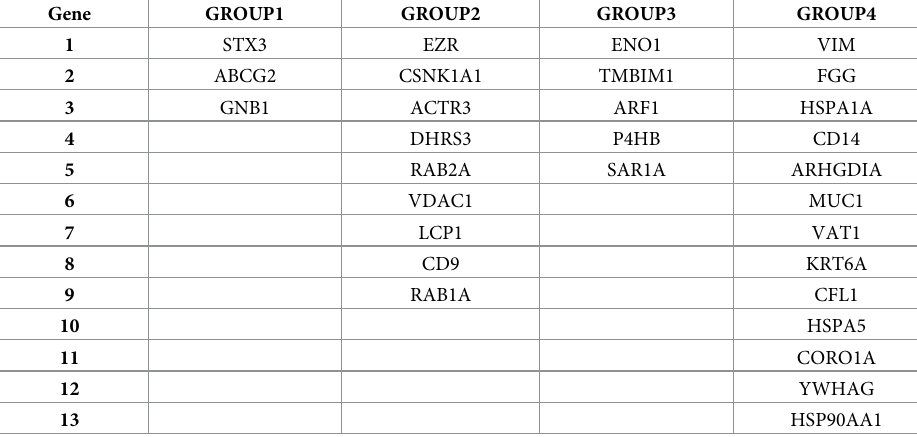
Table 2. Gene groups based on DFT average clustering results.